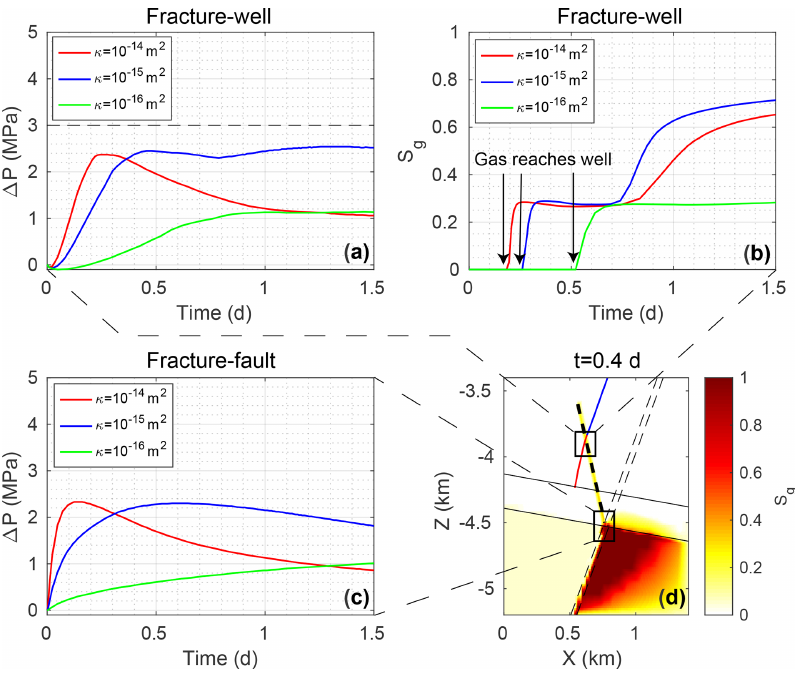
Figure 9. (a) Pressure change over time for different permeability values of the broken fault seal at the fracture zone/well intersection ( z (cid:39) − 3 . 9km). The dashed black line at 3MPa marks the approximate pressure of the plateau in Fig. 8, which is considered as a maximum overpressure that could have been caused by the gas (see text). Zero-time corresponds to the breach of the seal to initiate the gas kick. (b) Gas saturation over time for different permeability values of the broken fault seal at the fracture zone/well intersection ( z (cid:39) − 3 . 9km). (c) Pressure change over time for different permeability values of the broken fault seal at the fracture zone/fault intersection ( z (cid:39) − 4 . 5km, i.e., close to the breached seal). (d) Gas saturation after ca. 0.4d at y = 0km (normal to the fault, along profile A–A (cid:48) in Fig.